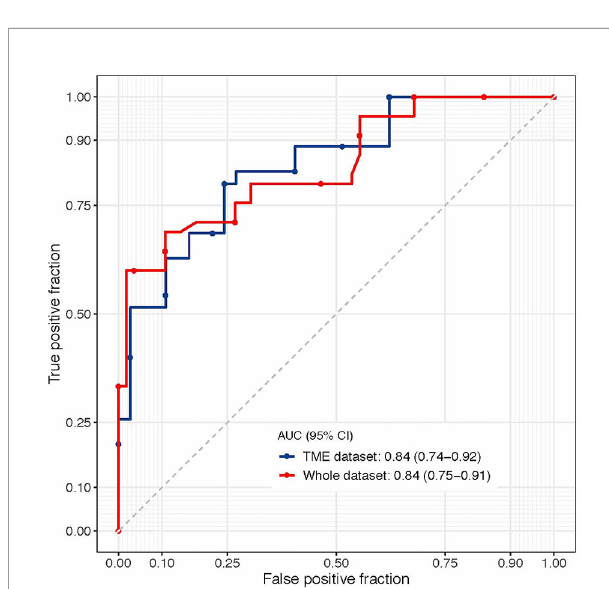
FIGURE 4 | The ROC of the fi nal model (incorporating adjusted-thickness and regularity of the shape).